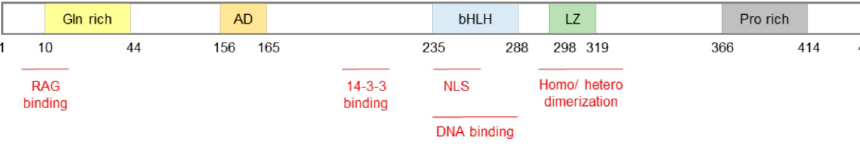
Figure 1. Representation of TFEB functional domains. TFEB contains N-term transcriptional activation domain (AD), basic helix-loop-helix region (bHLH), leucine zipper (LZ), and proline-rich domain (Pro-rich). Numbers indicate amino acid location in TFEB protein.